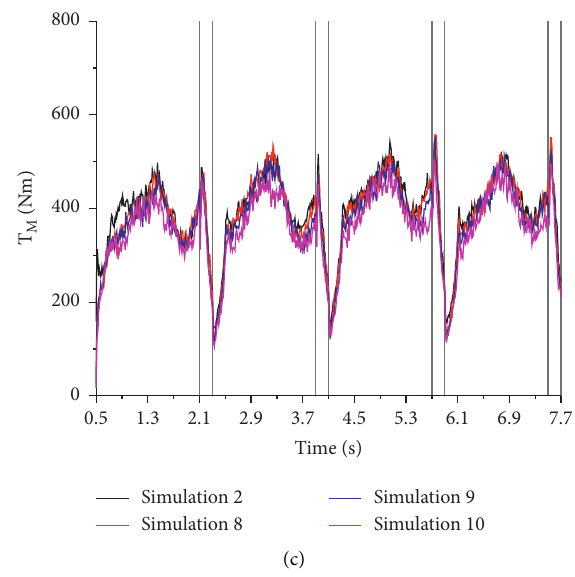
Figure 19: The variation of the stirring resistance torque with time.